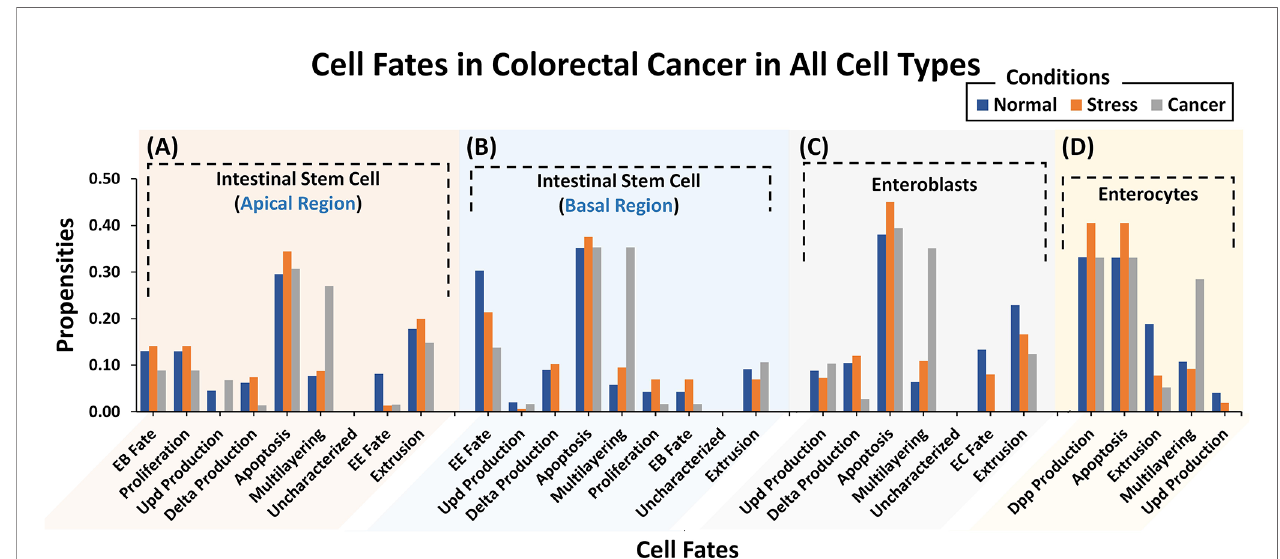
FIGURE 2 | Cell fate propensities for intestinal stem cells (ISCs) under Apical and Basal regulation, enteroblasts (EBs), and enterocytes (ECs) in normal, stress , and cancer conditions. (A) ISC ’ s under Apical regulation adopt eight different cell fates in three ambient conditions. In normal conditions, the highest propensity was observed for apoptosis followed by extrusion, proliferation, and EB fate, in order. In the case of stress , the highest propensity is that of apoptosis, followed by extrusion, EB fate, and proliferation. In cancer, the highest propensity is that of apologies followed by multi-layering and extrusion. (B) ISCs under Basal regulation program eight different cell fates with the highest propensity being for apoptosis fate in normal , stress , and cancer conditions. (C) Six cellular fates in EB, with the highest propensity for apoptosis in normal , stress , and cancer conditions. (D) Five cellular fates in EC, with the highest propensity for dpp production and apoptosis in normal, stress , and cancer conditions. Uncharacterized cell fate has a 0.000 propensity in all conditions and every